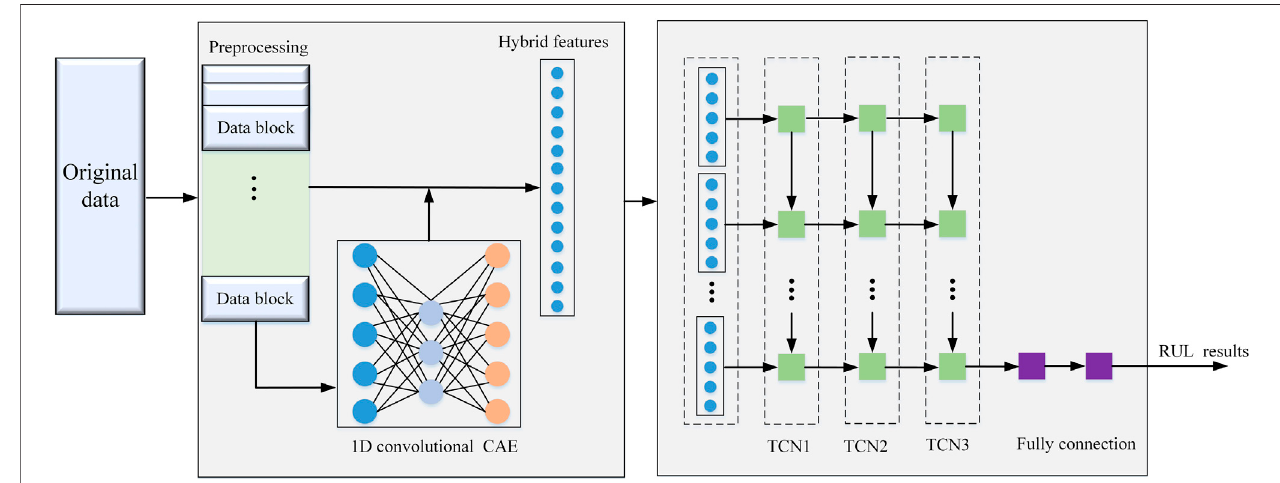
FIGURE 4 | The complete architecture of the RUL predictive